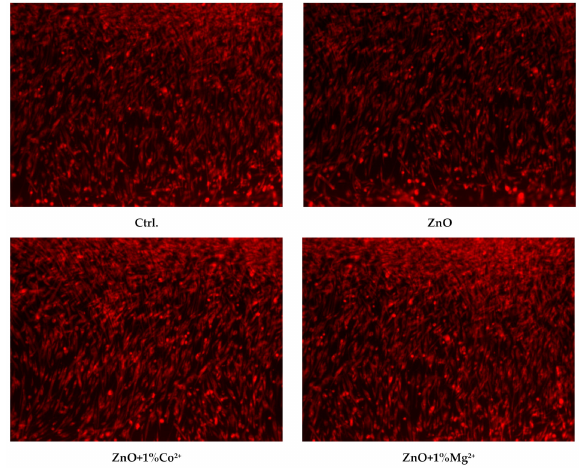
Figure 9. The fluorescence microscopy images performed on undoped and Co 2 + / Mg 2 + doped ZnO films coatings on TiAlV alloy